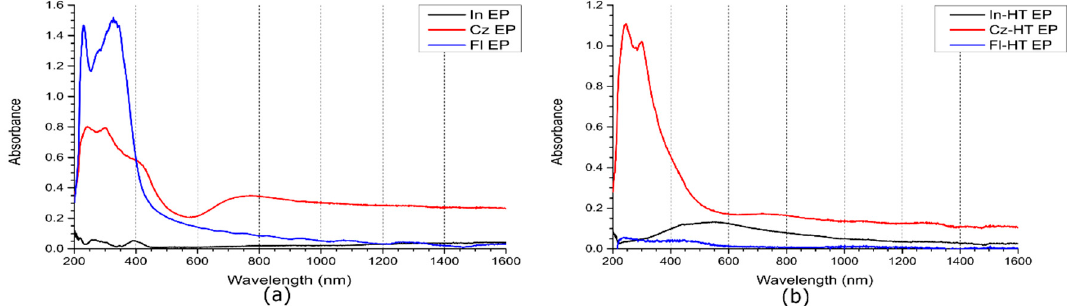
Figure 10. Ultraviolet-visible-near infrared (UV-Vis) spectra of polymeric films prepared from pure monomer solutions ( a ) and monomer solutions containing HT ( b ).